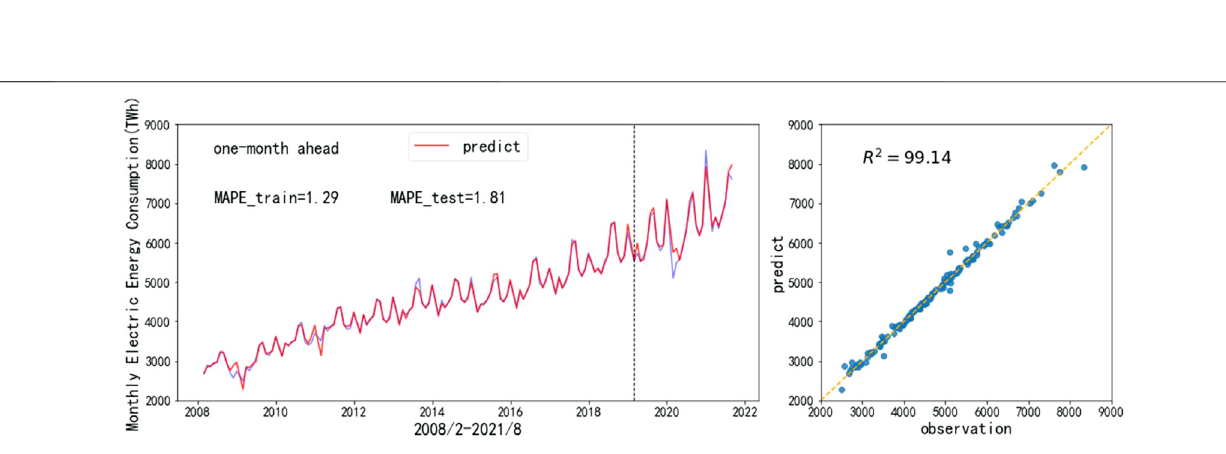
FIGURE 8 | Comparison between different models for 3-month ahead forecasting.